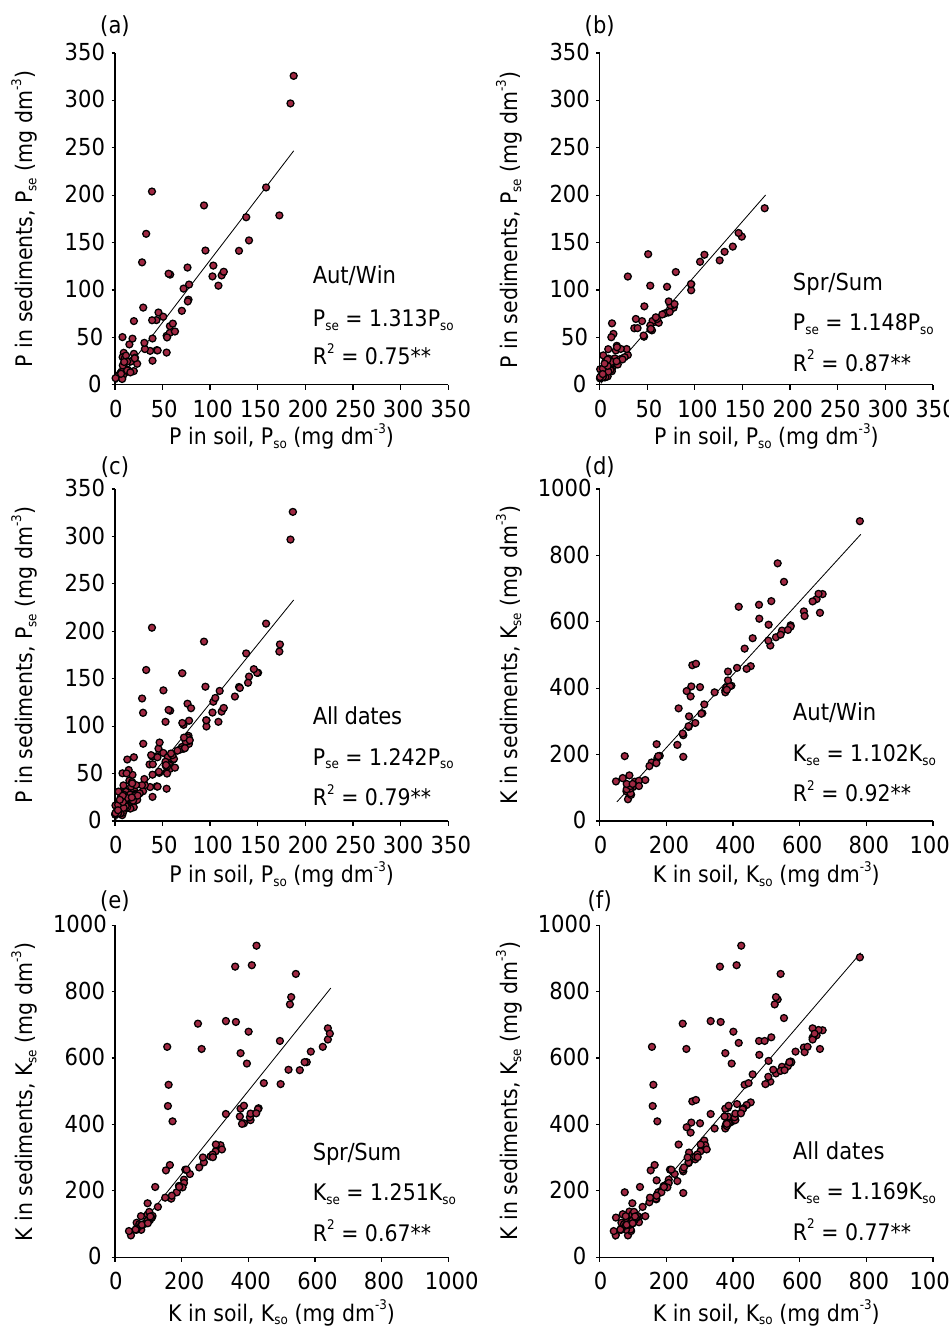
Figure 1. Relationship between extractable phosphorus contents (a), (b), and (c) and exchangeable potassium (d), (e), and (f) in eroded sediments and in the soil layer from 0 to 0.025 m, in a Humic Cambisol for 15 years under natural rainfall conditions. P se : phosphorus in the sediments; P so : phosphorus in the soil; K se : potassium in the sediments; K so : potassium in the soil; Aut/Win: autumn/winter; Spr/Sum: